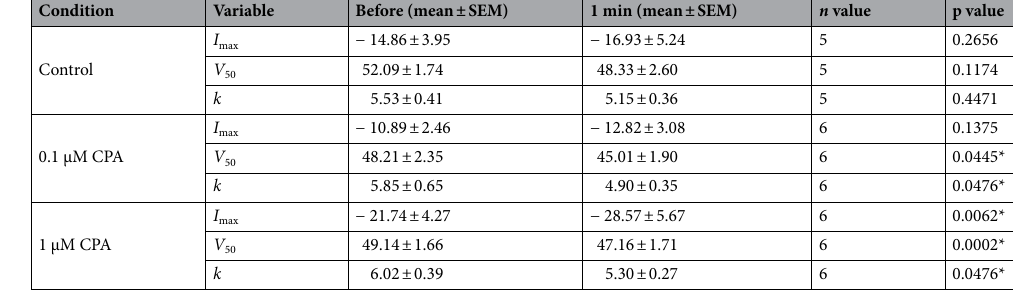
Table 1. Results of fits of two-state Boltzmann equation before and immediately after solution change. Three conditions shown, giving mean ± SEM values for between-patch maximum current, I max (pA/µm 2 ), half maximal voltage, V 50 (mV) and steepness factor, k (mV). Significance of paired differences between results obtained before and 1 min following solution change expressed as the p value obtained from within-patch two- tailed paired Student’s t test. *Denotes a significant difference where p < 0.05.